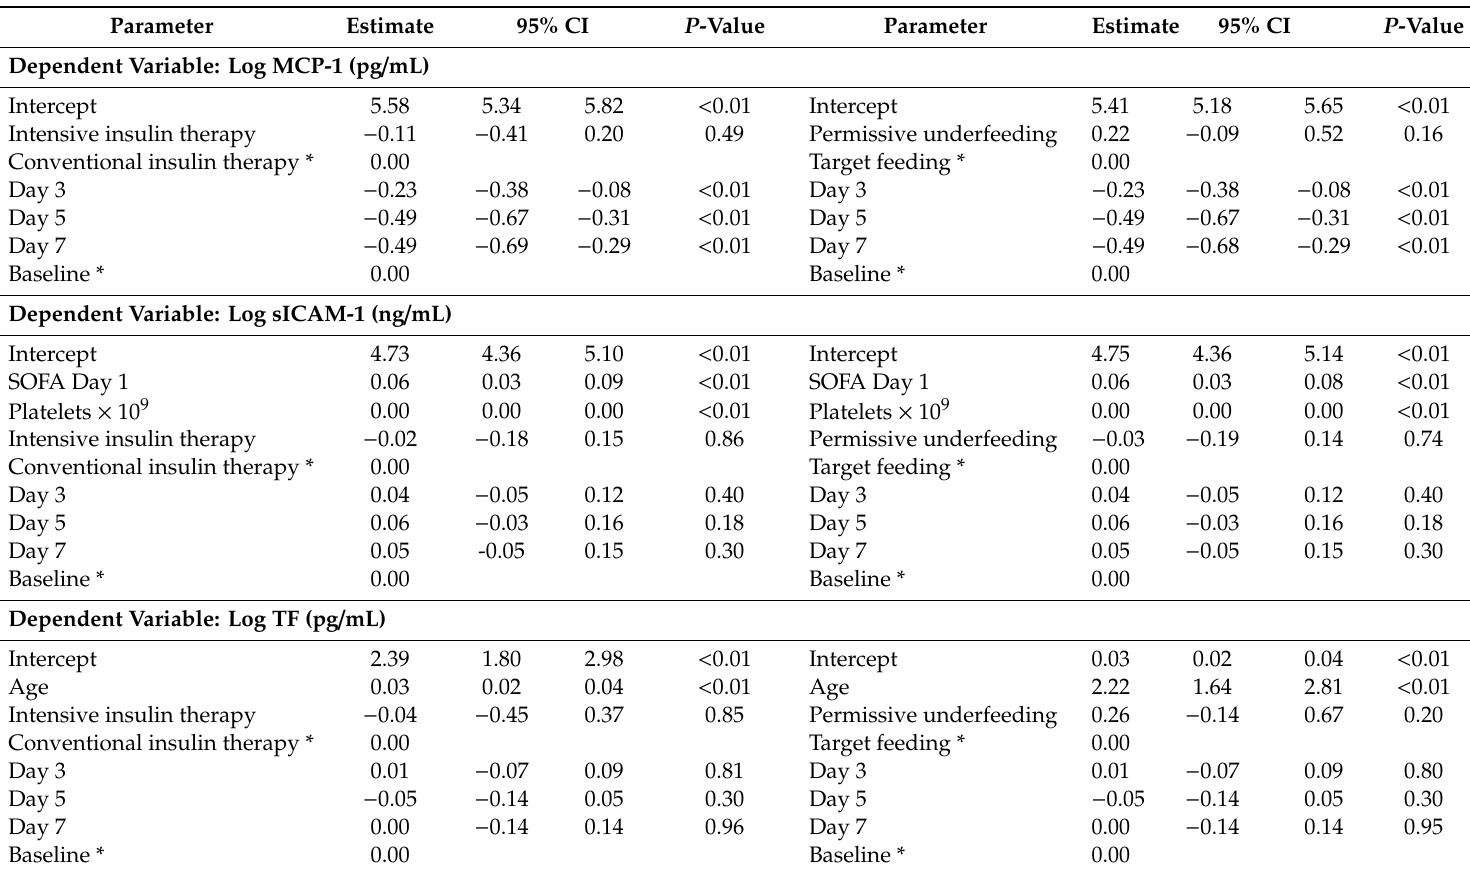
Table 4. Linear mixed models of plasma inflammatory mediators / biomarkers measured by time and randomization. Parameter Estimate